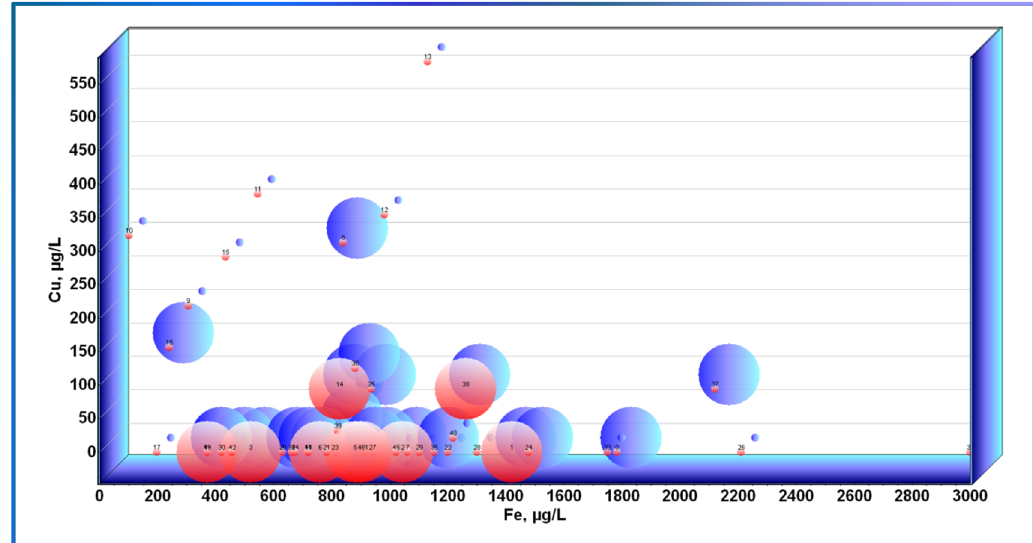
Figure 8. Bubble plot of the Fe and Cu concentrations combined interaction on TC ( blue ) and E. coli ( red ).